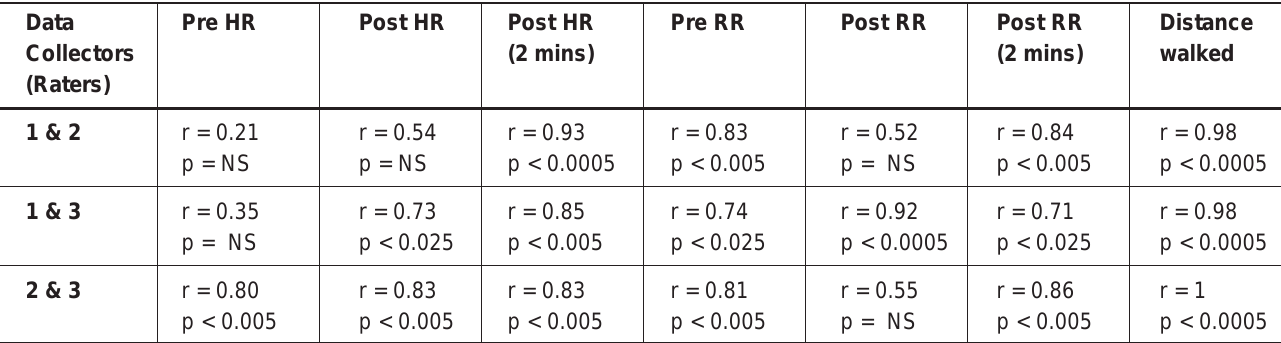
Table 2: Pearson product moment correlation coefficient results for 6-minute walk test – week 2 (df =